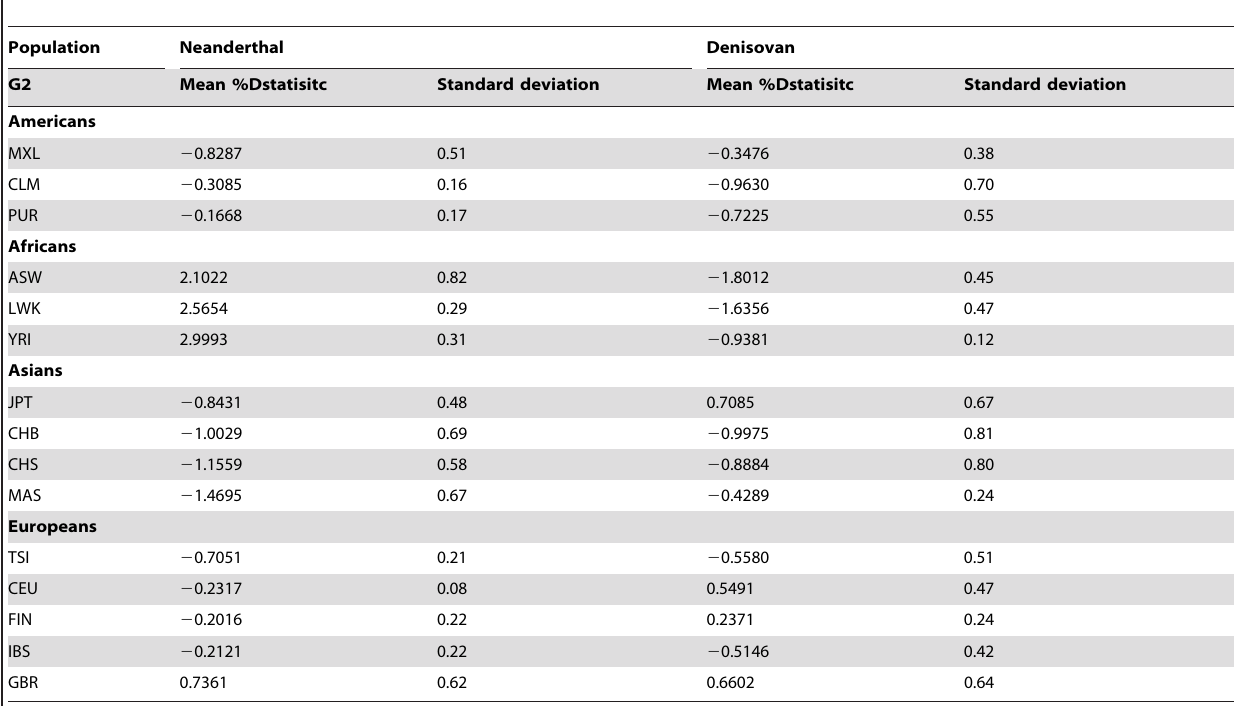
Table 5. Dstatistic analysis with ancient genomes for 5 randomly selected paired samples from each population from 1KGP and SSMP, anchored with a different SSIP sample (G1) and the chimpanzee genome in each of the 5